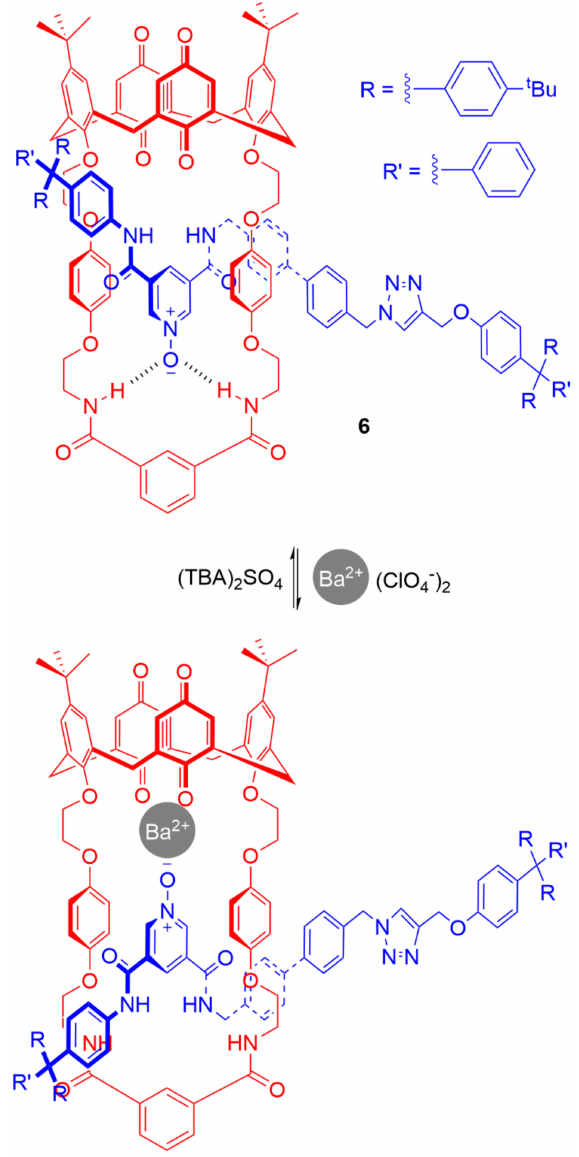
Figure 6. Hancock and Beer’s pirouetting calix [4]diquinone–isophthalamide macrobicycle rotaxane 6